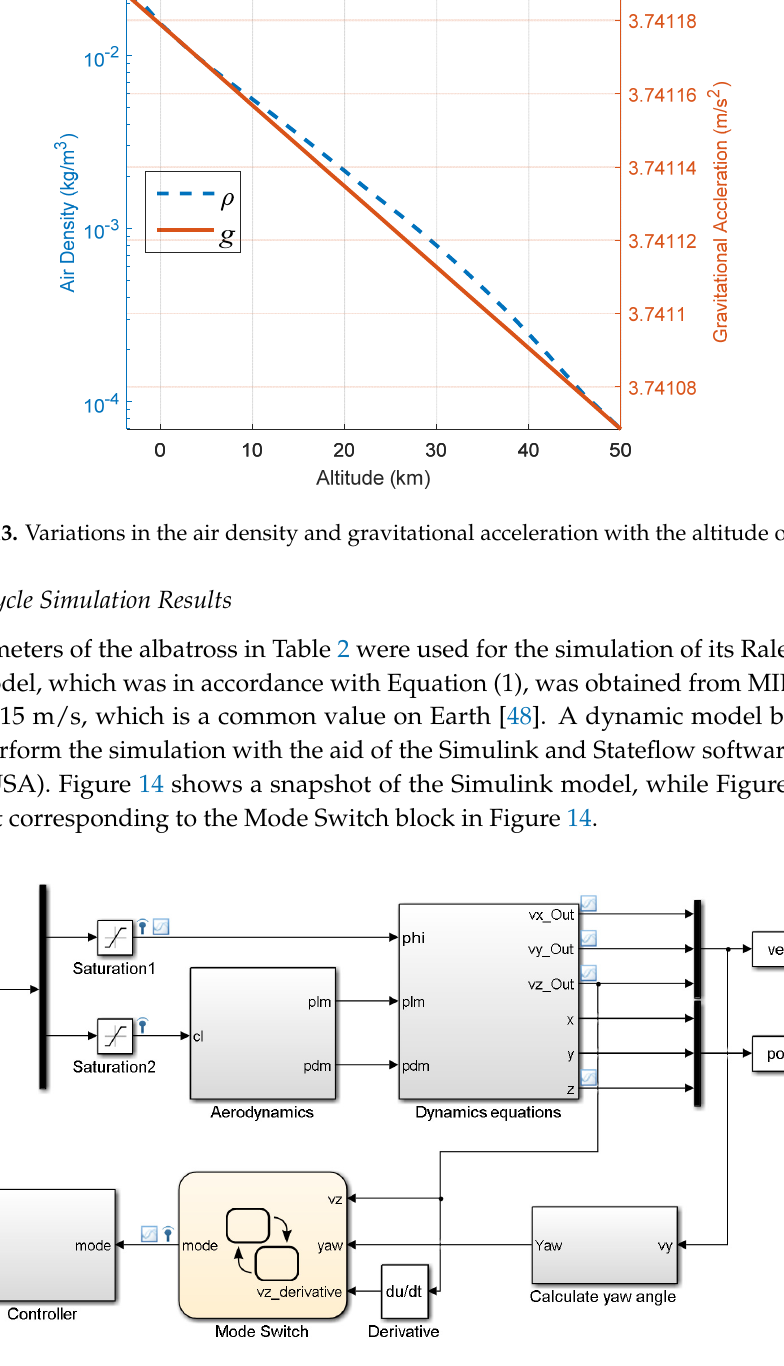
Figure 14. Snapshot of the Simulink model.